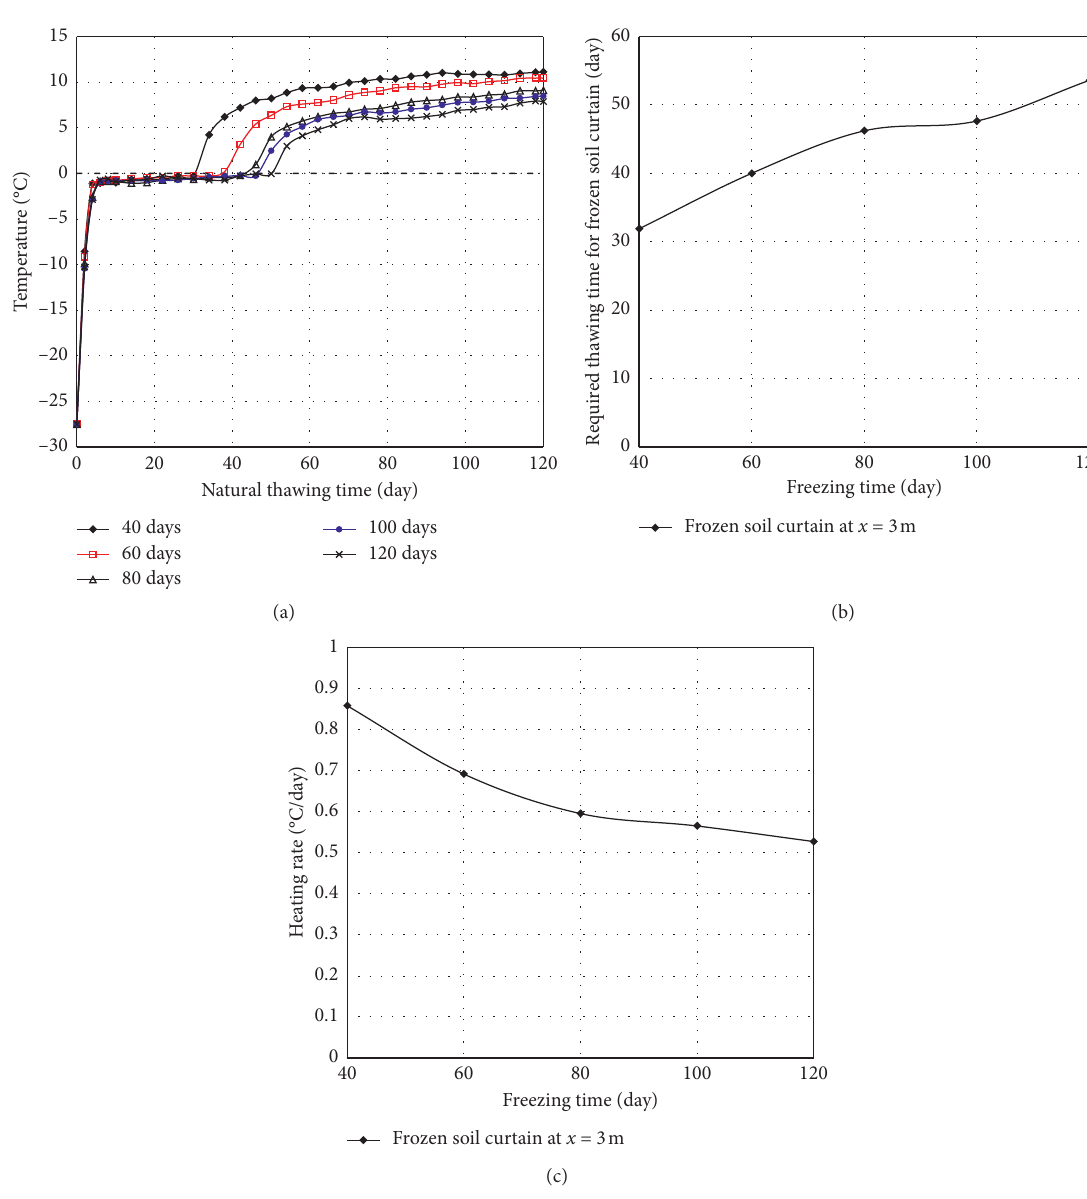
Figure 16: Effects of freezing time on the temperature-thawing time response and required thawing time for frozen soil curtain: (a) temperature-thawing time response at X � 3m (monitor point 2); (b) variation of required thawing time with freezing time; (c) variation of heating rate with freezing